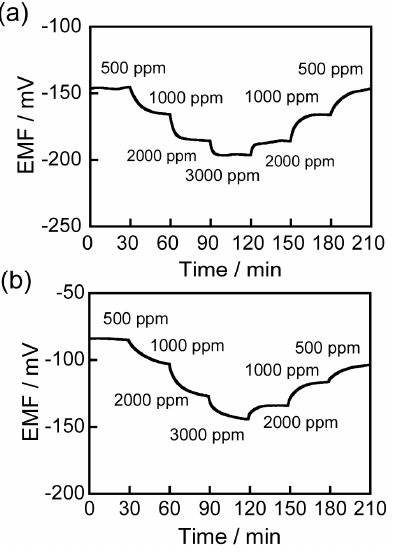
Figure 3. Representative sensor response curves measured by the sensors using the auxiliary sensing electrodes (a) with and (b) without 10 wt% PMMA for SO 2 gas concentrations between 500 to 3000 ppm at 400 °C. Figure 4. Relationship between the sensor EMF output and log( P SO 2 ) for the sensors using the auxiliary sensing electrodes (a) with and (b) without 10 wt% PMMA. ● and □ represent the sensor EMF outputs with increasing and decreasing SO 2 gas concentrations, respectively. The solid line shows the theoretical slope estimated from the Nernst equation.